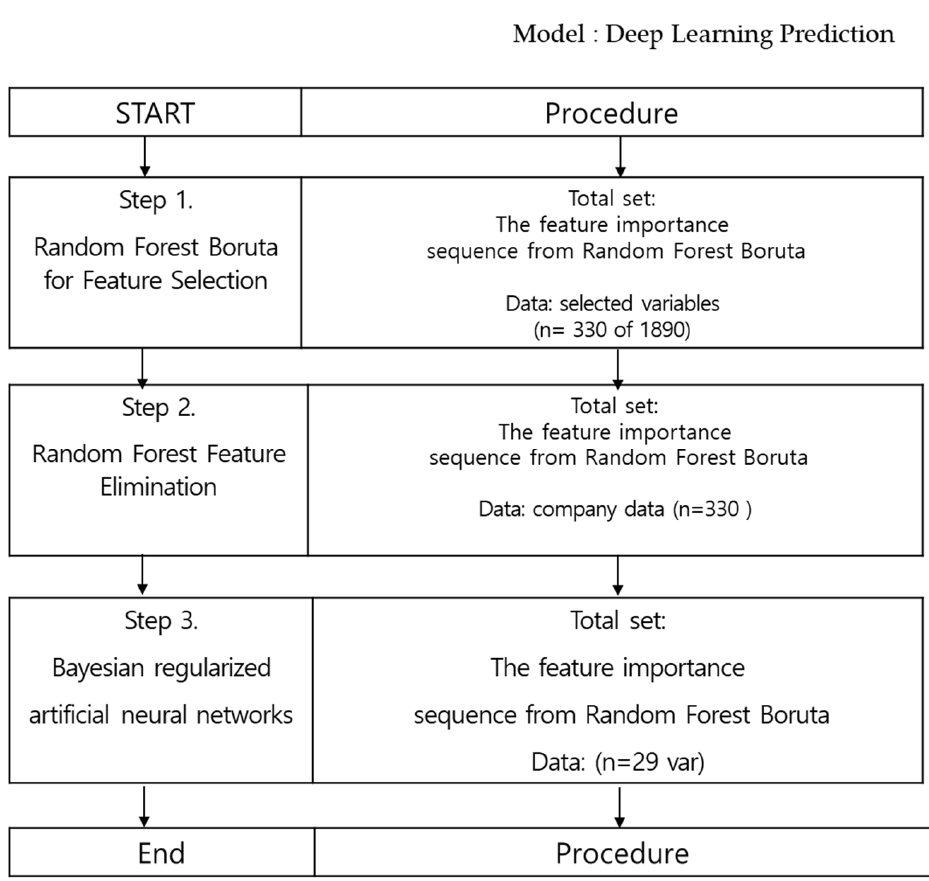
Figure 2. Analytic Algorithm Methodology. Source: Authors’ construction.